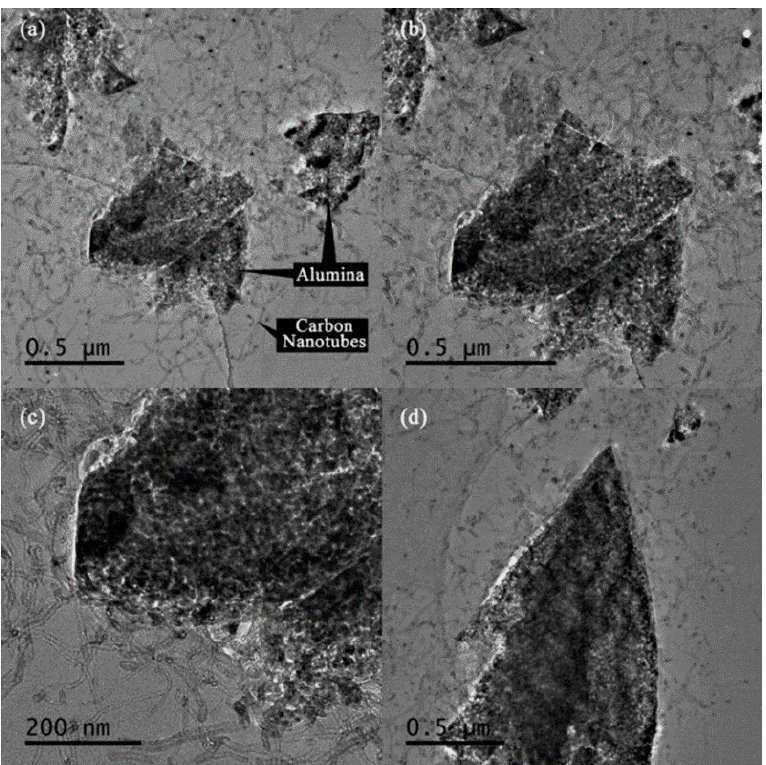
Figure 1. HRTEM images of CNT/alumina hybrid in epoxy composites [7] at different magnifications. ( a ) 9900×; ( b ) 15,000×; ( c ) 29,000×; ( d ) 12,000×. The thermal stability of the CNT/alumina epoxy composites was evaluated using TGA in a nitrogen atmosphere at heating rates of 5, 10, and 20 °C min − 1 . The mass residue versus the temperature curve of the thermal degradation for the composites based on the corresponding filler loadings at different heating rates are shown in Figure 2.